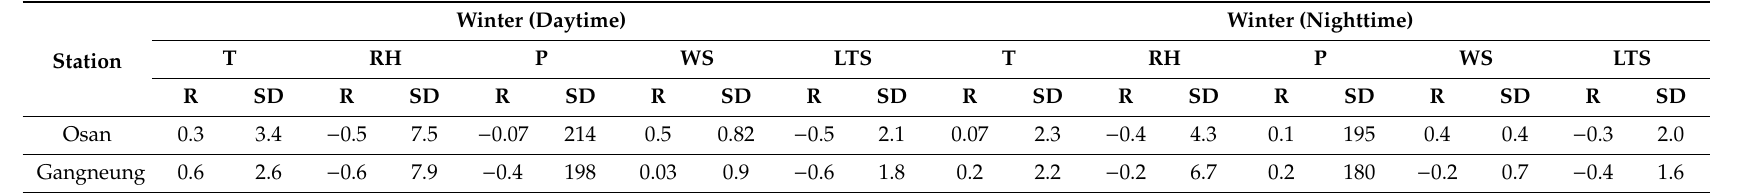
Table 1. Correlations between PBLH and meteorological parameters during winter.